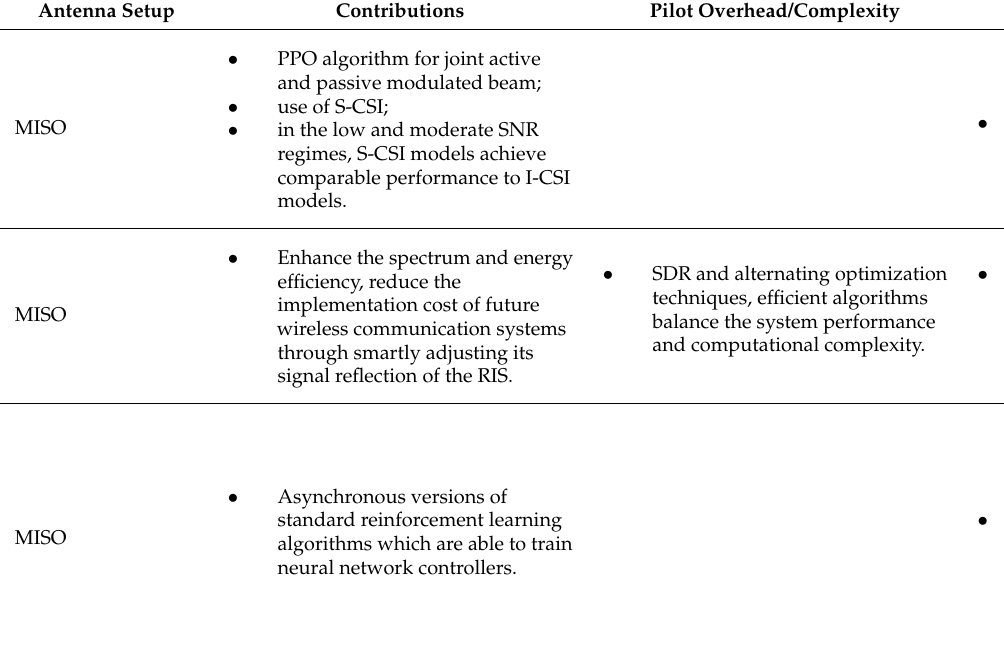
Table 2. Contributions of the proposed methods in RIS-assisted communication